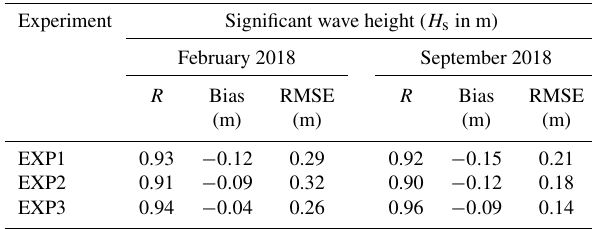
Table 3. Skill scores for the sensitivity